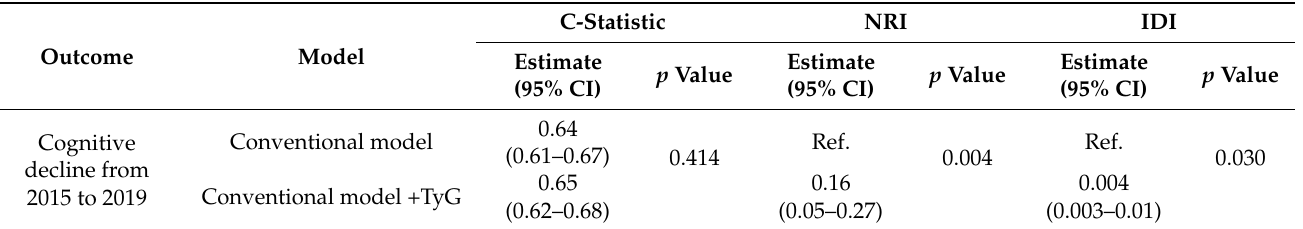
Table 4. Reclassification and disclination statistics for the clinical outcome when adding to the TyG